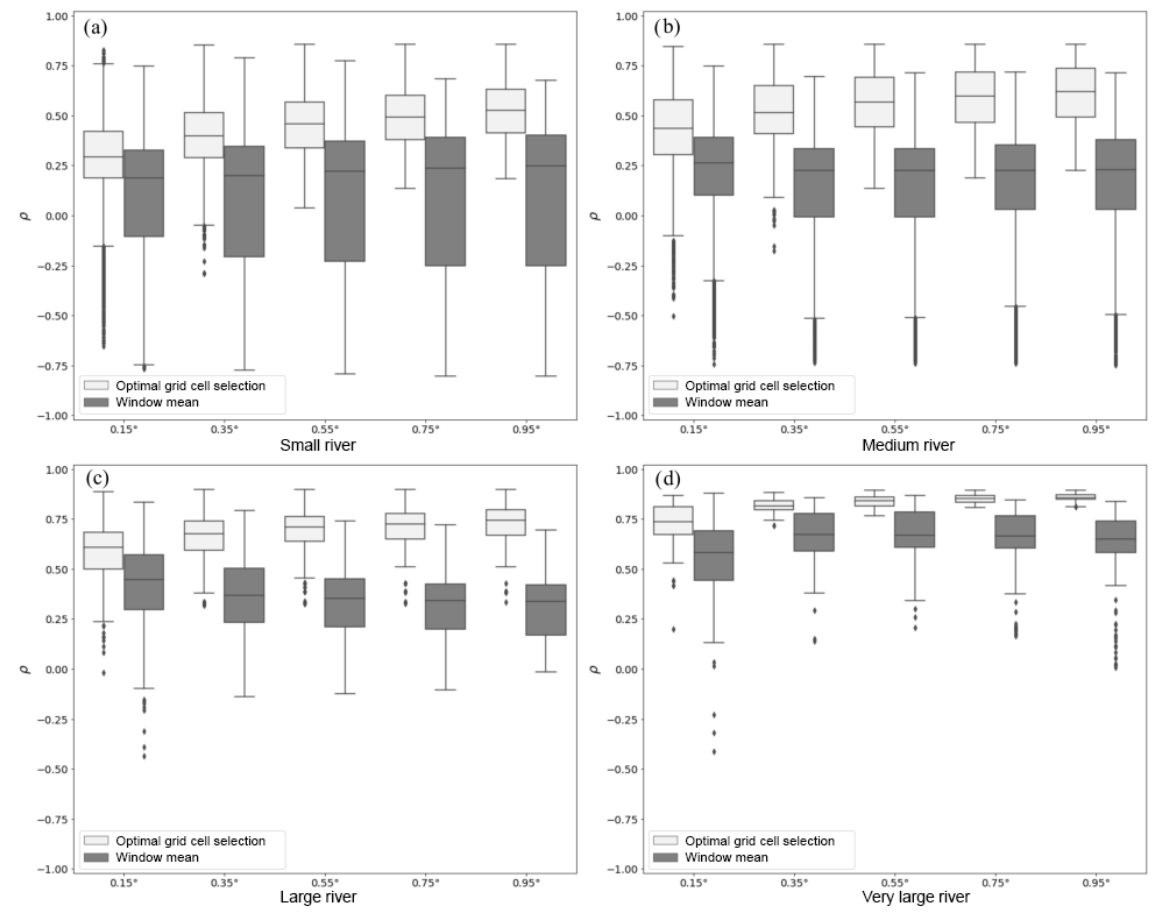
Figure 3. Distributions of Spearman’s rank correlation between MODIS water extent and simulated storage using different window sizes (0 . 15 ◦ × 0 . 15 ◦ , 0 . 35 ◦ × 0 . 35 ◦ , 0 . 55 ◦ × 0 . 55 ◦ , 0 . 75 ◦ × 0 . 75 ◦ , and 0 . 95 ◦ × 0 . 95 ◦ ) and two approaches (light grey: optimal grid cell selection (method A); dark grey: window mean (method B)) in four categories of river flow across the Amazon Basin. Outliers are data beyond the distance larger than 1.5 times the interquartile range from the first and third